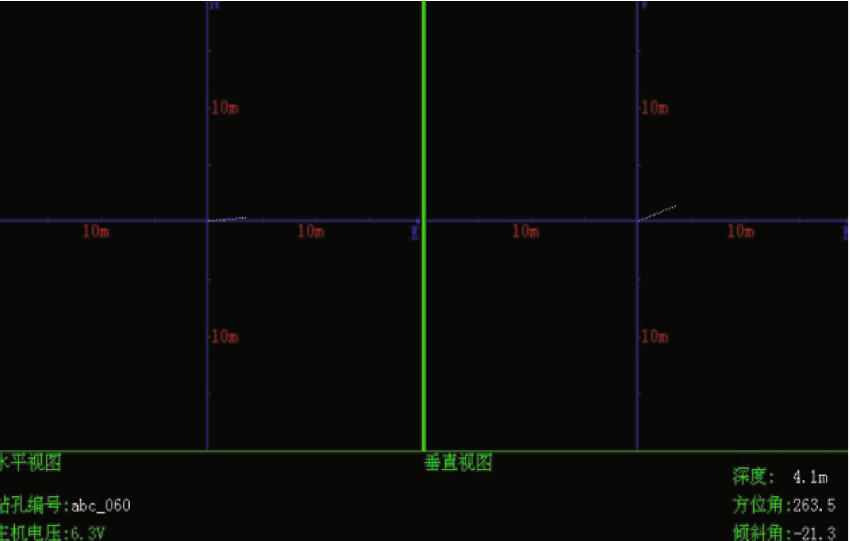
Figure 5: Image acquisition